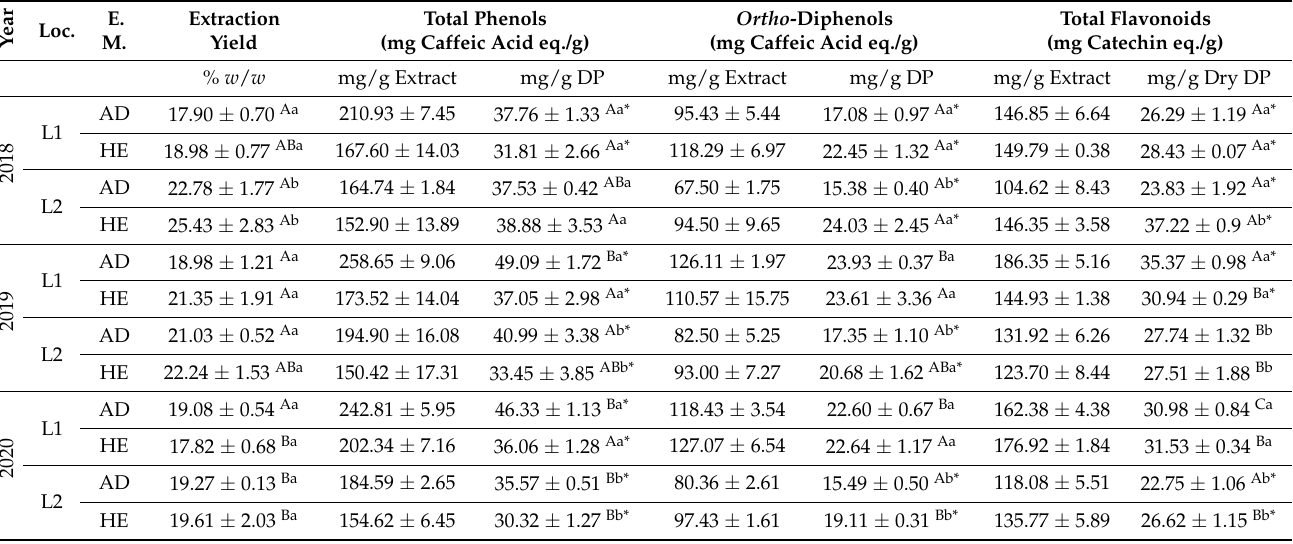
Table 1. Extraction yields and total phenolics, ortho -diphenols, and flavonoid content of Thymus carnosus